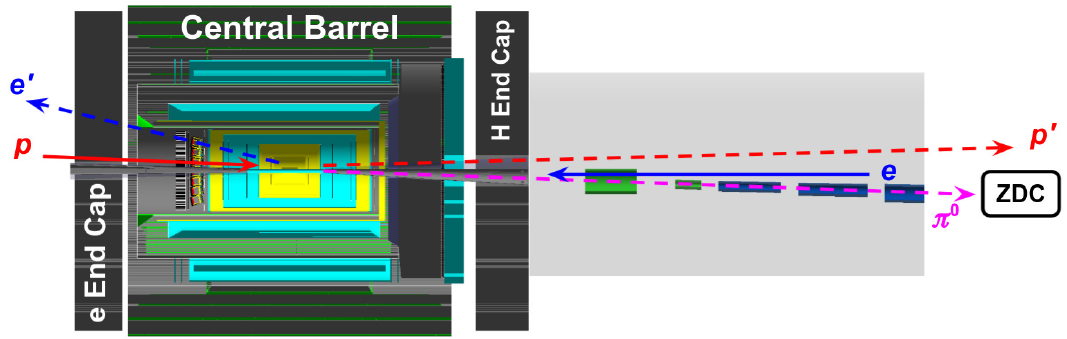
Figure 4: Schematic display of a typical u -Channel π 0 electroproduction event at EIC. Solid lines represent the beam particles and dashed lines represent the final state